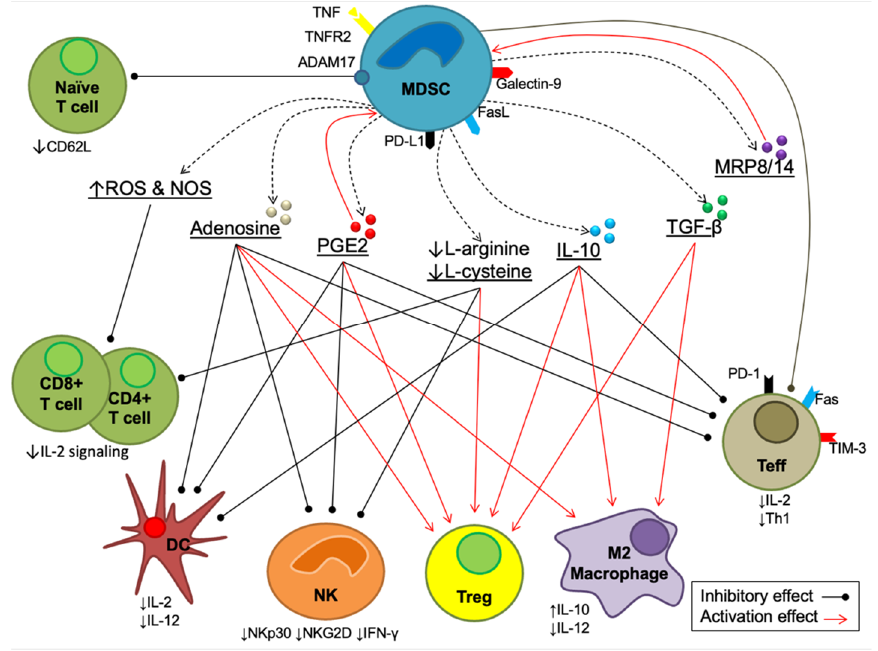
Figure 2. The immunosuppressive mechanisms mediated by MDSCs. There are four main mecha- nisms, as mentioned above. Each mechanism is explained in full in the following sections.